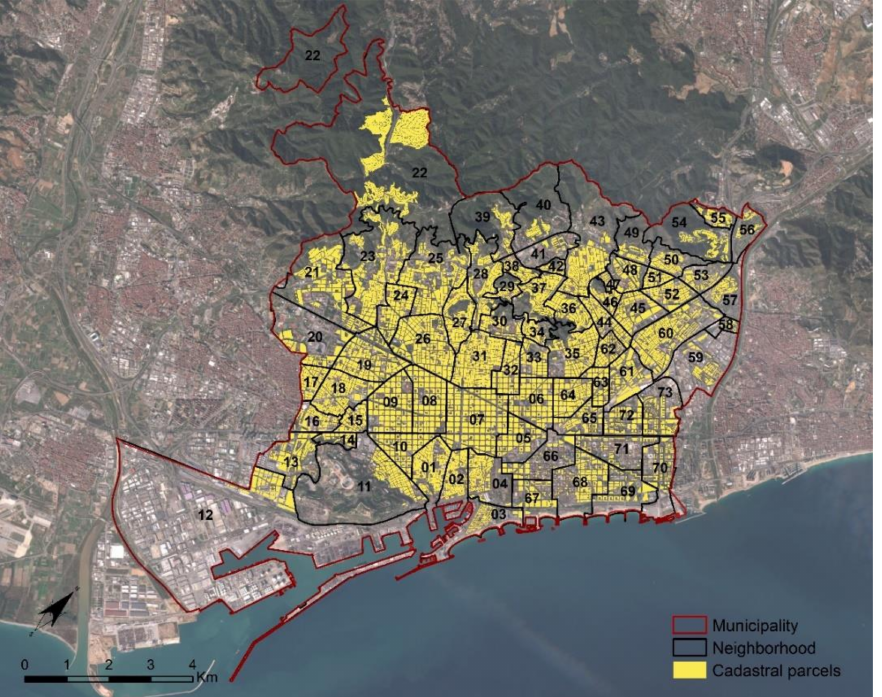
Figure 1. The City of Barcelona. Its 73 administrative neighborhoods and cadastral parcels. Source: own production derived from the 1: 5000 Orthophoto from ICGC, used under a CC BY 4.0 license [41]. See Table A1 in Appendix A for the full list of neighborhood codes and names of Barcelona.